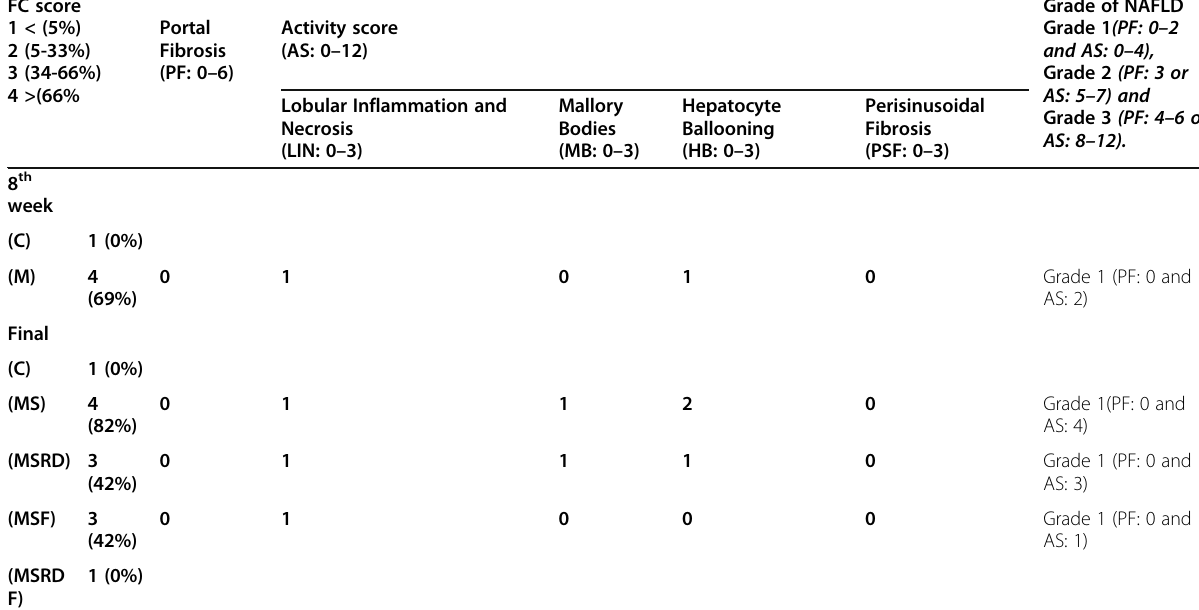
Table 7 Scoring of fatty change (FC score) and grading of NAFLD in the five study